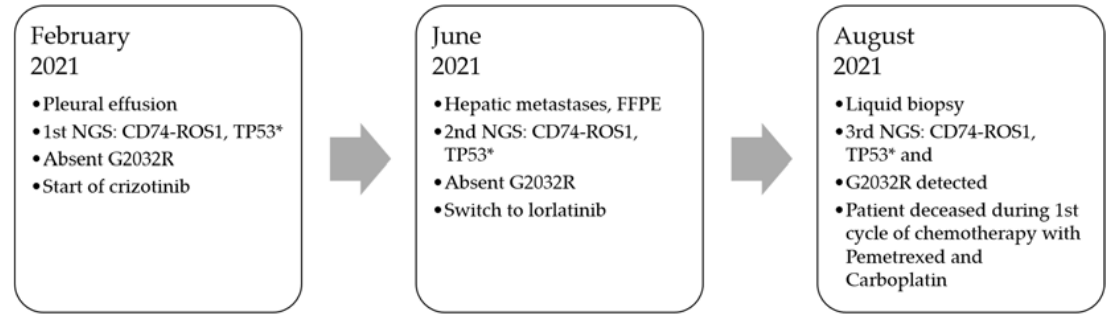
Figure 1. Summary of treatment plan and performed diagnostics.